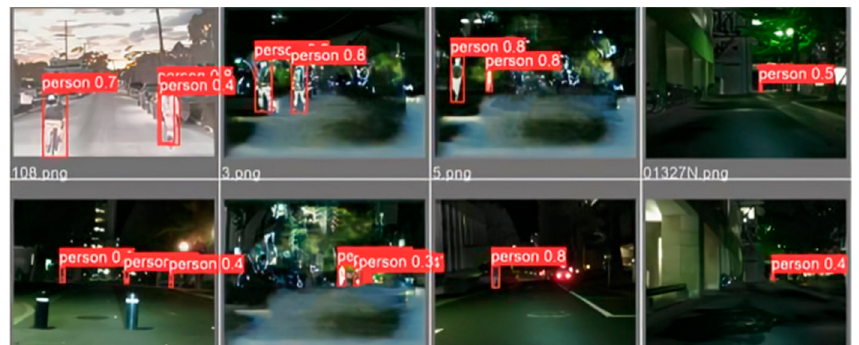
Figure 12. The detect effect on the augmented images by our methods. In Figure 13, the left nine images are original, and the right nine are enhanced images. After GAN augmentation, more useful objects emerged in the pictures. More people were seen in the dark. The comparison of the F1 score and confusion matrix are shown in the Figure 14.